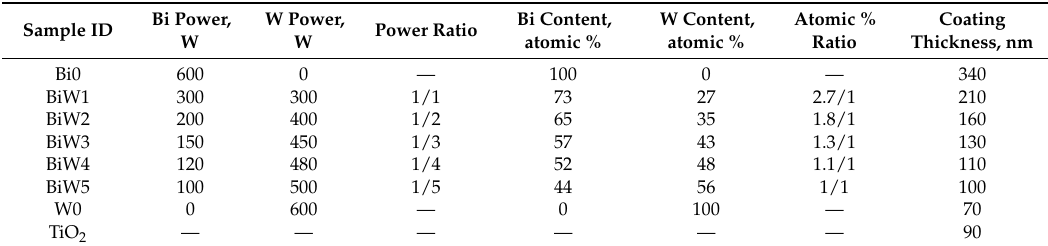
Table 1. Compositional properties and thickness of bismuth tungstate and titanium dioxide coatings deposited onto 2-mm glass